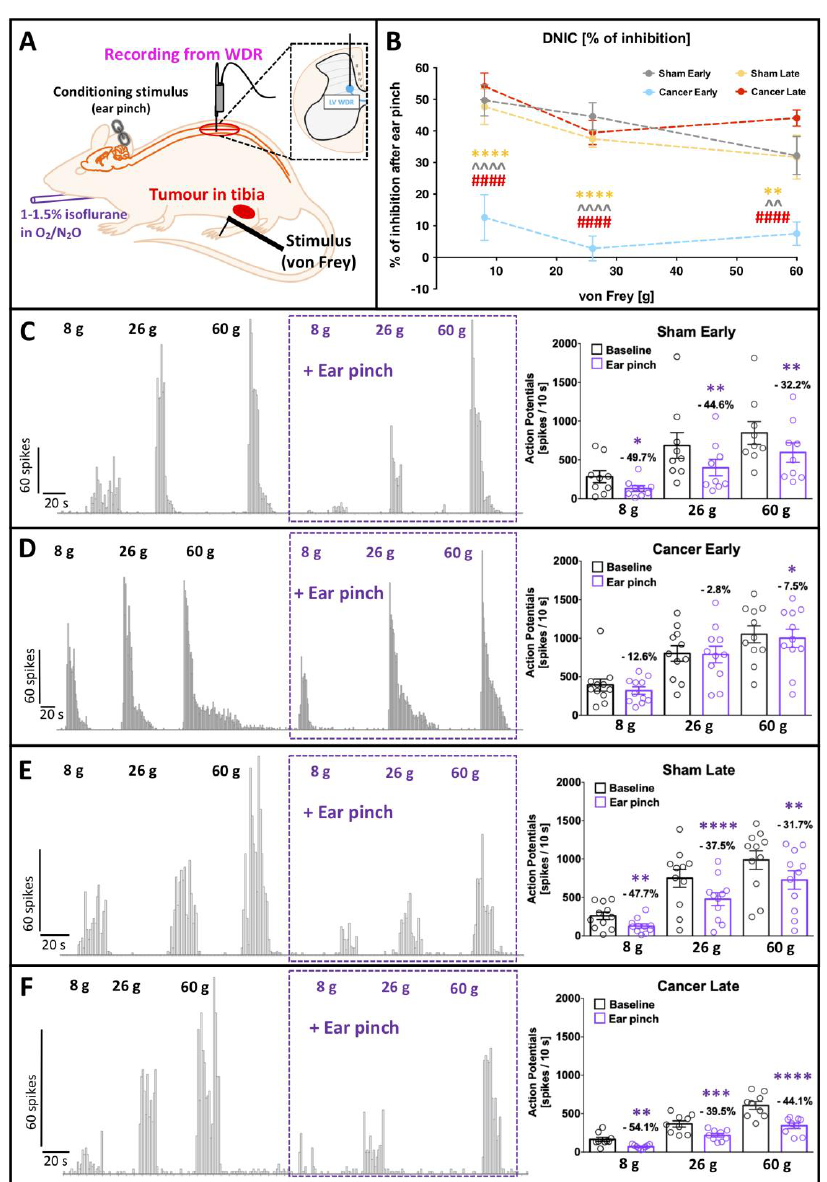
Figure 4. Di ff use noxious inhibitory control expression is compromised in early but not in the late cancer stage. ( A ) Schematic representation of the in vivo electrophysiological experiment. WDR— wide-dynamic range neurons. Activation of diffuse noxious inhibitory controls (DNIC) is quantified as a decrease in von Frey-evoked spinal WDR neuronal firing before (baseline; testing stimulus) and after concomitant application of noxious ear-pinch (DNIC; conditioning stimulus). ( B ) Magnitude of DNIC expression quantified as a percentage of WDR neuron inhibition following ear-pinch application in early (day 7–8) and late (day 14–16) cancer stage and corresponding sham-operated rats. One-way ANOVA with Bonferroni post-hoc: **** p < 0.0001 cancer early vs. sham late, ˆˆ p < 0.01, ˆˆˆˆ p < 0.0001 cancer early vs. sham early, #### p < 0.0001 cancer early vs. cancer late. ( C – F ) Example of deep WDR neuron responses to increasing bending force of von Frey filaments before and after ear pinch application in sham early ( C ), cancer early ( D ), sham late ( E ) and cancer late ( F ). Individual neuronal responses are quantified in the right panel. Values over each bar represent percentage of change to the respective baseline. Each cell values represent averaged responses from 3 consecutive trials and one cell was recorded per animal (shown as a single dot). Two-way RM ANOVA with Bonferroni post-hoc: * p < 0.05, ** p < 0.01, *** p < 0.001, **** p < 0.0001 vs. corresponding baseline. All the data represent the mean ± SEM from sham early ( n = 9), cancer early ( n = 11), sham late ( n = 11) and cancer late ( n =